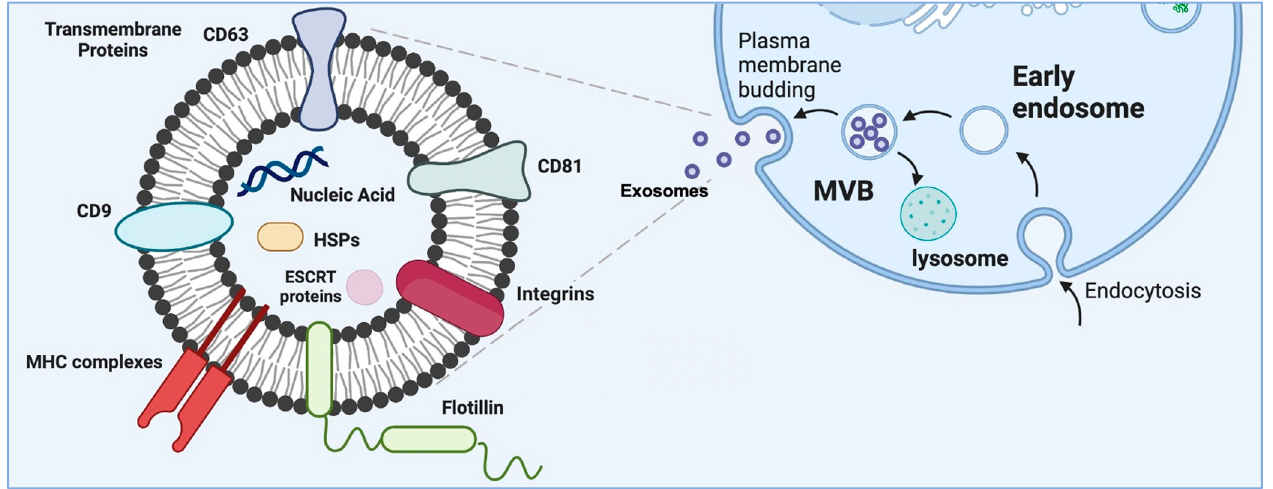
Figure 1. Biogenesis and main components of exosomes.